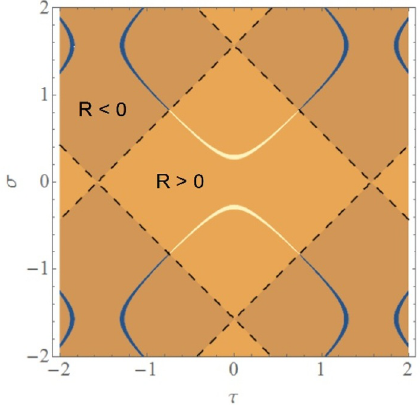
Figure 26 . Induced scalar curvature of the analytical solution in flat space (with a = 5 ). Dashed lines indicate where the curvature changes sign. Cusps on the string correspond to the blue/white curves in the figure. The worldlines are subluminal (superluminal) in the R > 0 ( R < 0 )